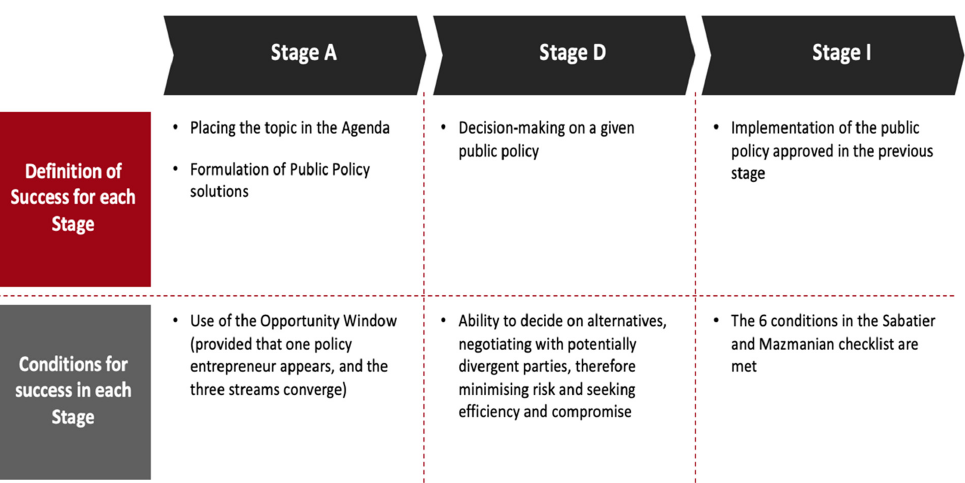
Table 2. Some Examples of Categories and their CISFs . Category